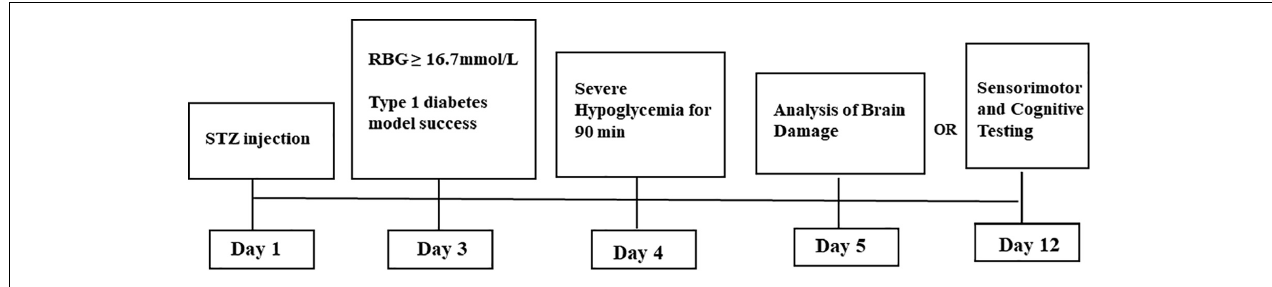
FIGURE 1 | Experimental